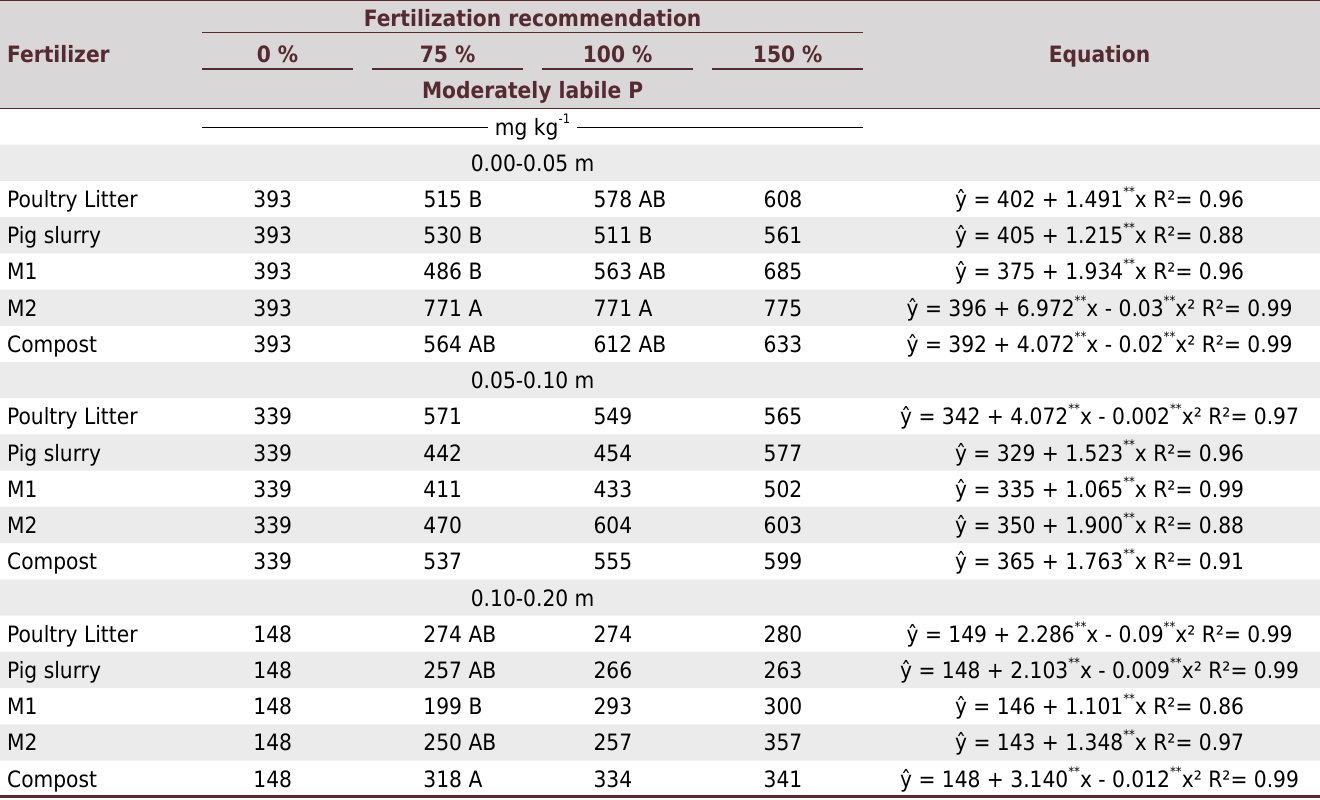
Table 5. Moderately labile soil phosphorus fraction extracted by NaOH 0.1 mol L -1 in the 0.00-0.05, 0.05-0.10, and 0.10-0.20 m layers after six years use of organic and mineral fertilizers in a Rhodic Kandiudox